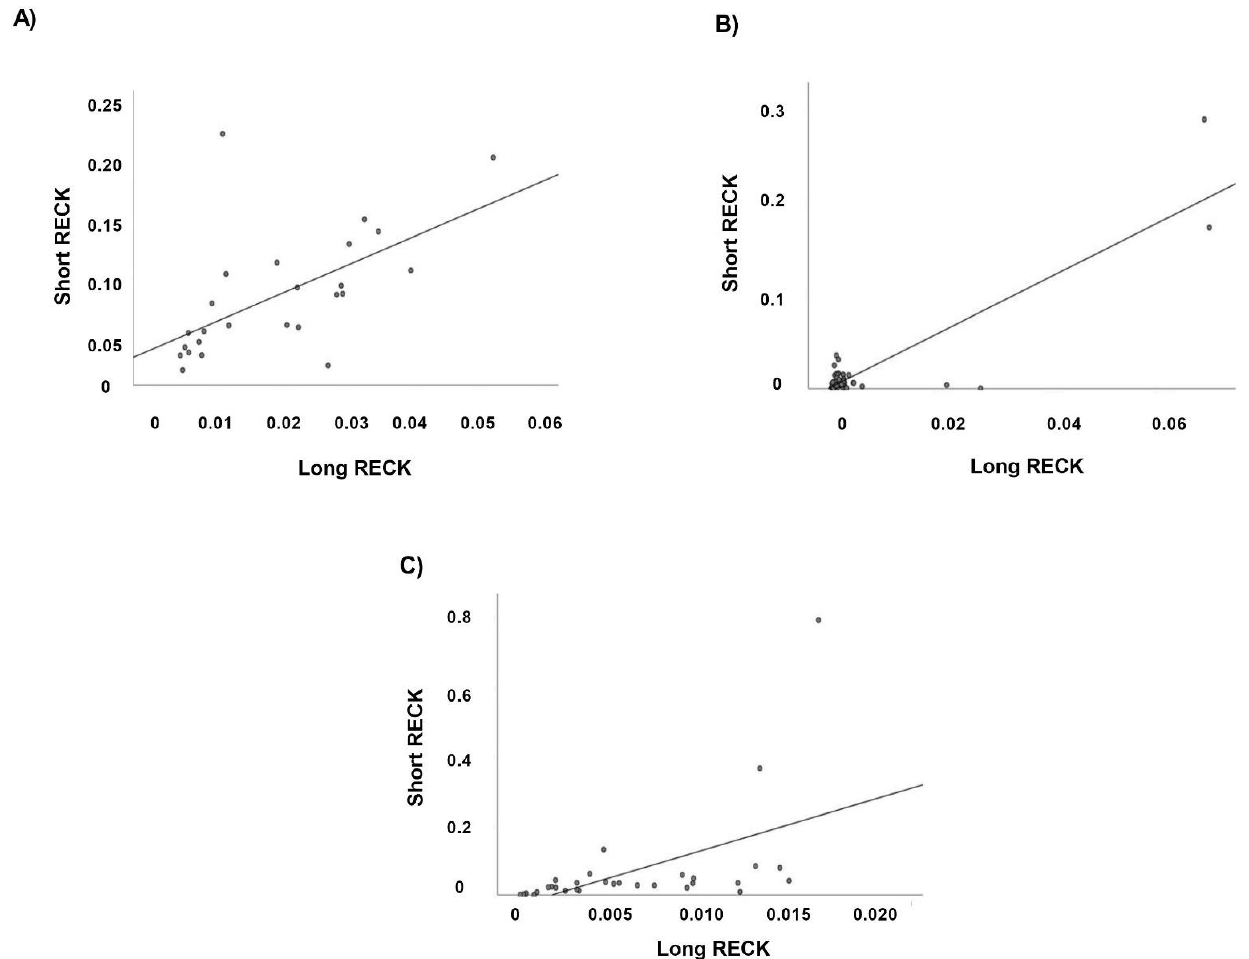
Figure 6. Correlation analysis of Long and Short RECK splice variants in all case study. Scatter plots depict the relationship between the two RECK splice variants in ( A ) CTR ( R 2 = 0.355, p < 0.005, Pearson r = 0.601); ( B ) CAD ( R 2 = 0.793, p < 0.0001, Pearson r = 0.890); ( C ) AMI ( R 2 = 0.279, p < 0.005, Pearson r = 0.528).